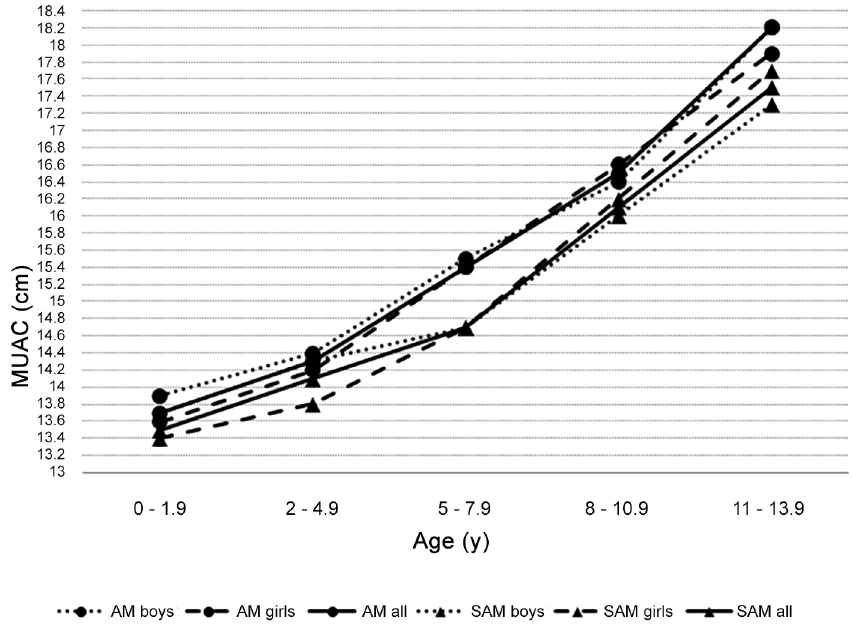
Fig 1. Optimal cut-offs for acute malnutrition (AM) and severe acute malnutrition (SAM) by age group and gender.